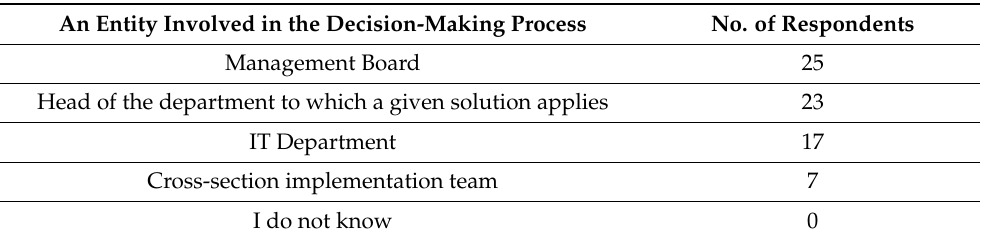
Table 11. A unit involved in the decision-making process to implement Industry 4.0 solutions.